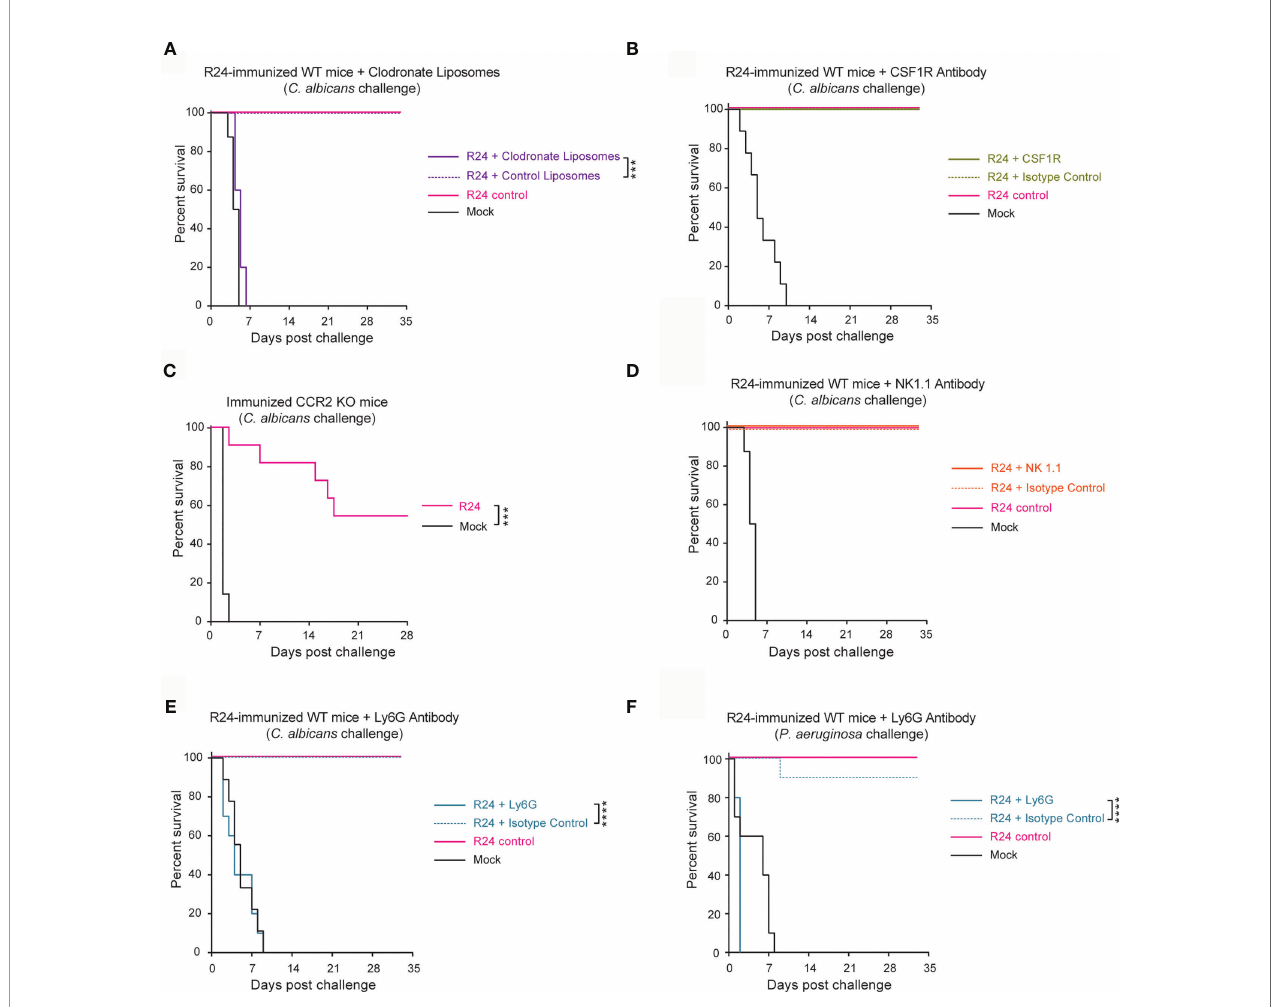
FIGURE 3 | Gut-evolved C. albicans R24-induced protection from systemic fungal infections is mediated by neutrophils. (A) WT mice systemically immunized with C. albicans R24 were injected at day 7 post-immunization with either clodronate liposomes or control liposomes (purchased from http://clodronateliposomes.com) i.v. at 200 µl liposome suspension/mouse every other day. Animals were challenged at day 14 post-immunization with the lethal dose of the WT C. albicans (SC5314) (5x10 5 CFUs). 100% of mice immunized with the gut evolved strain (R24) succumbed after systemic challenge by WT SC5314 when treated with clodronate liposomes, but not with the control liposomes. Macrophages were speci fi cally depleted using CSF1R neutralizing antibody (B) and the role of monocyte recruitment was studied in CCR2 − / − mice (C). NK cells and neutrophils were speci fi cally depleted using NK1.1 neutralizing antibody (D) or Ly6G neutralizing antibody (E) , respectively. None of the immunized mice succumbed after systemic challenge by WT SC5314 when treated with CSF1R or NK1.1 antibodies, while the immunized mice treated with the Ly6G neutralizing antibody succumbed to the challenge with a lethal dose of the WT C. albicans (E) , or with a lethal dose of P. aeruginosa (F) . n = 10 mice/group. Log-rank survival test was performed in Prism v9. *** P < 0.001, **** P <